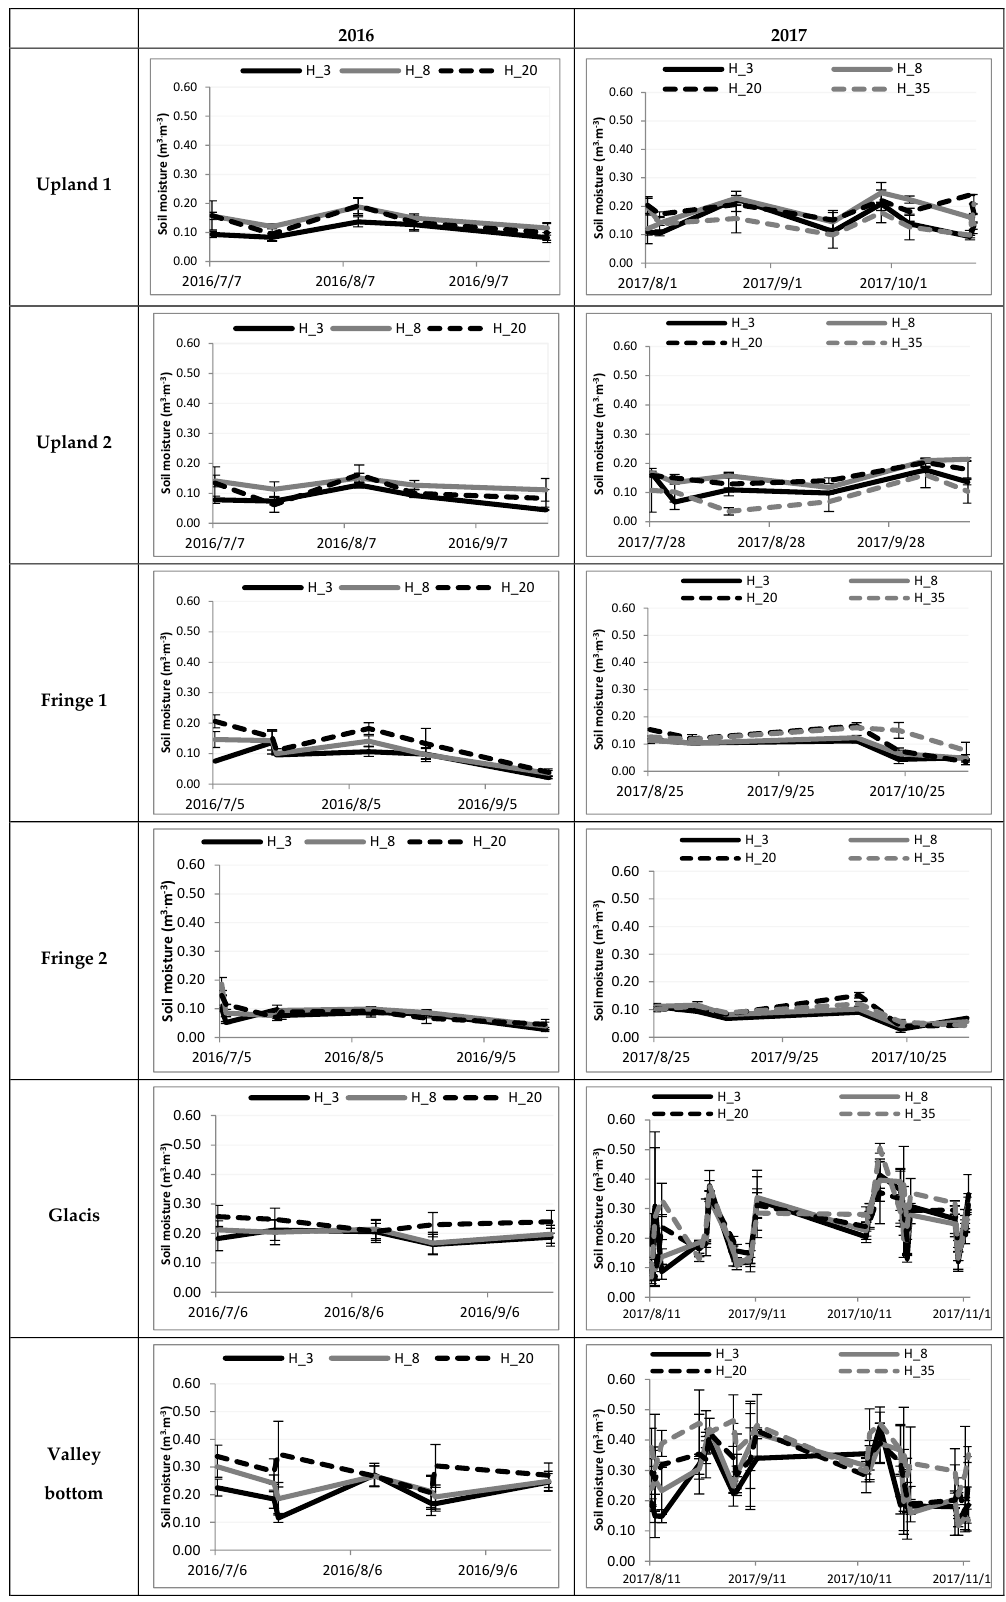
Figure 5. Soil moisture at di ff erent soil depths during the 2016 and 2017 growing seasons. Error bars indicate the standard errors of the